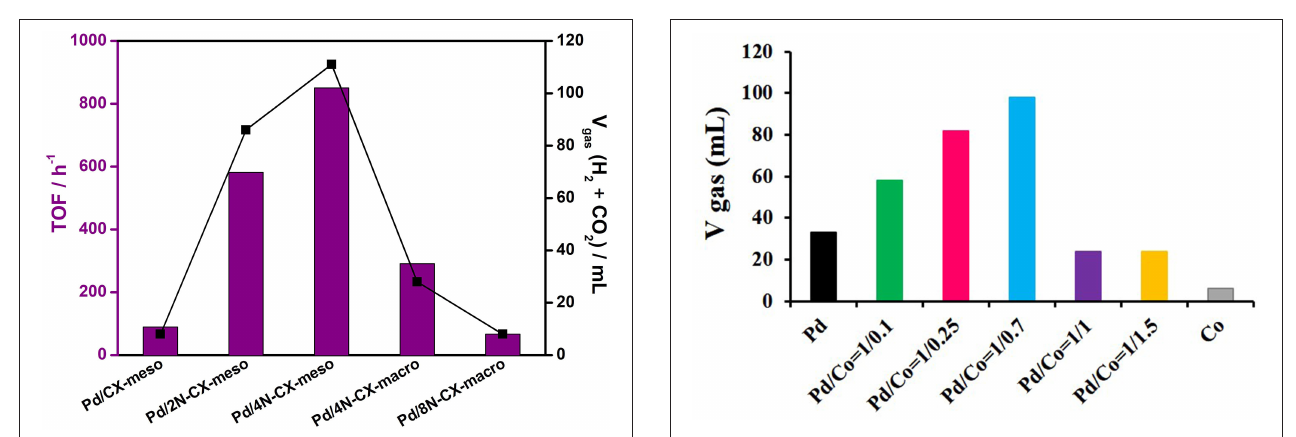
FIGURE 8 | TOF (calculated at 10min of reaction) and V gas (H 2 + CO 2 ) generated from the formic acid dehydrogenation reaction (75 ◦ C).